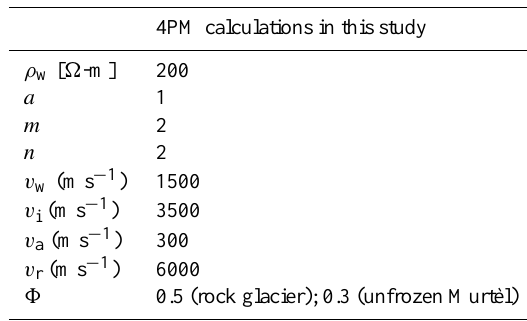
Table 1. Model parameters used for 4PM calculations for the two rock glaciers Murt`el and Muragl in the Eastern Swiss Alps (after King et al., 1988; Hauck and Kneisel,